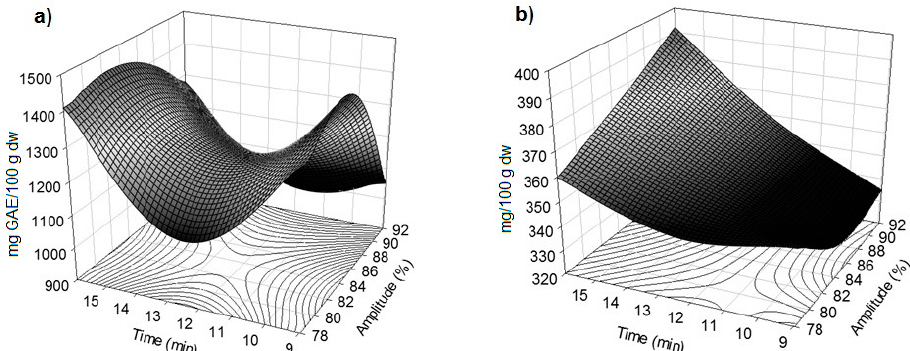
Figure 1. Response surface plots showing the effect of amplitude and time on ( a ) total phenolic content (mg gallic acid equivalent/100 g dry weight basis) and ( b ) anthocyanins (mg cyanidin-3-glucoside/100 g dry weight basis) of blackberry residues extracted by ultrasound.